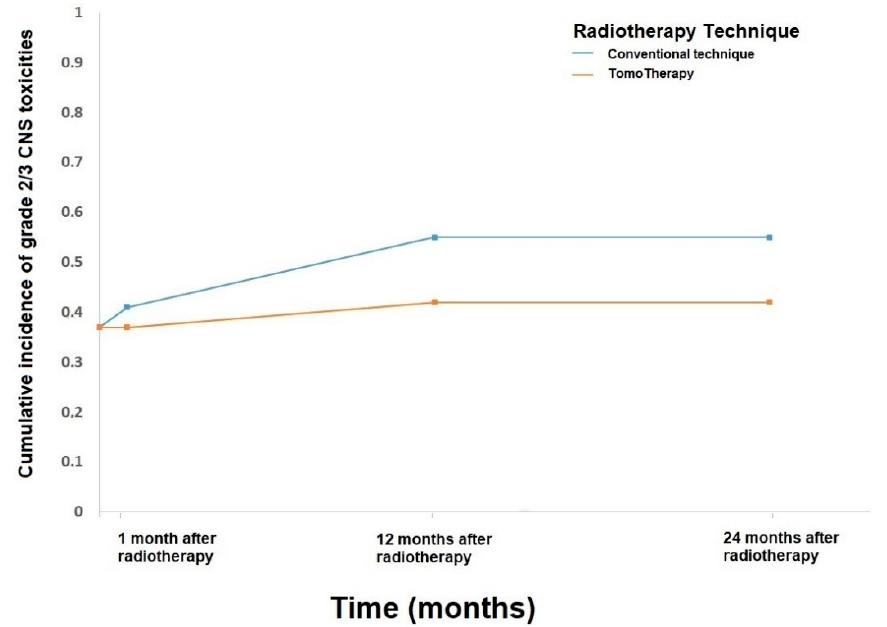
Figure 2. Cumulative incidence curve of grade 2/3 central nervous system (CNS) toxicities accord- ing to radiation